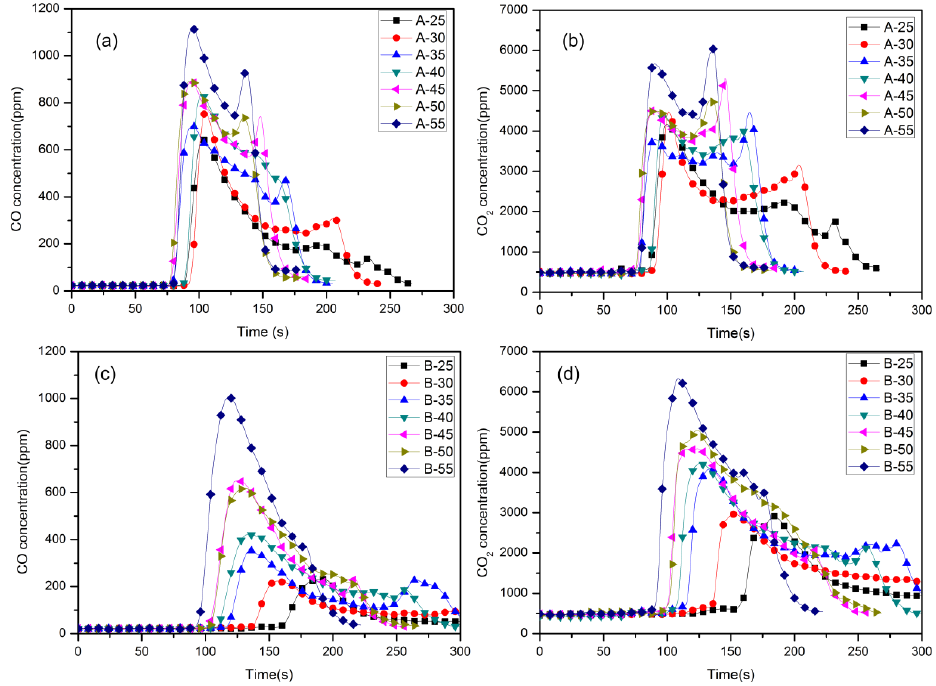
Figure 9. CO and CO 2 concentration of material in different heat fluxes.